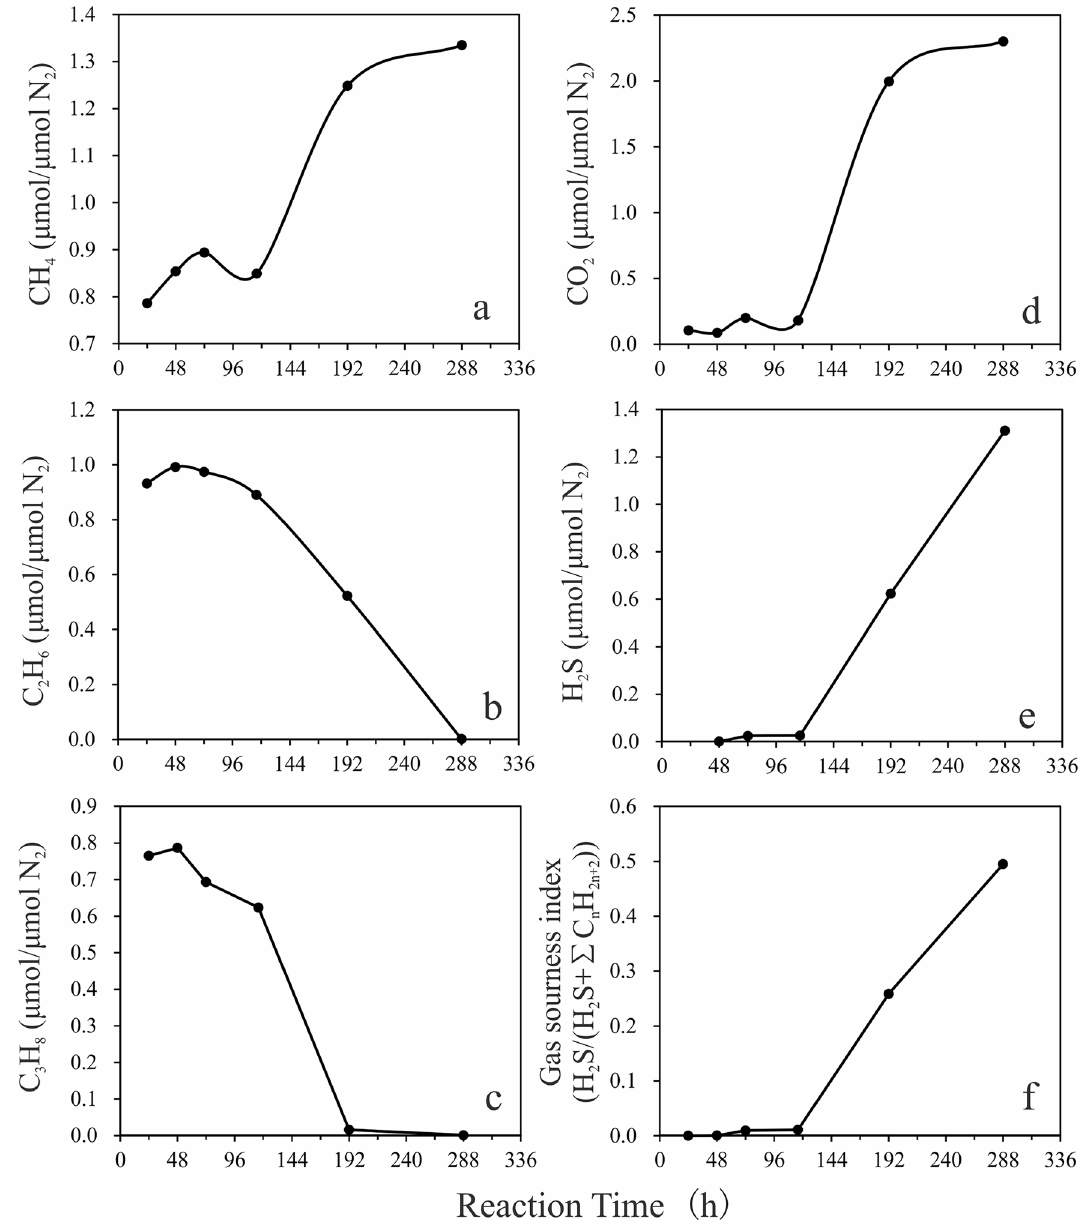
Figure 3. Variations in the contents of CH 4 ( a ), C 2 H 6 ( b ), C 3 H 8 ( c ), CO 2 ( d ), and H 2 S ( e ) and in the gas sourness index